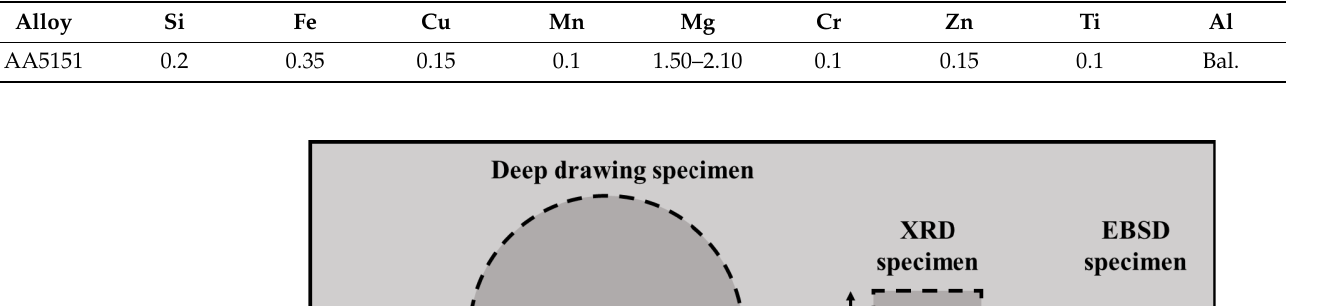
Table 1. Chemical composition of AA5151 aluminum alloy (wt%).